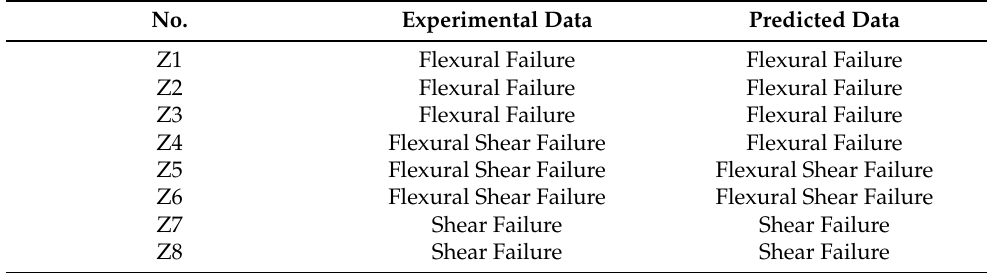
Table 11. Comparison of experimental data and predicted data for failure